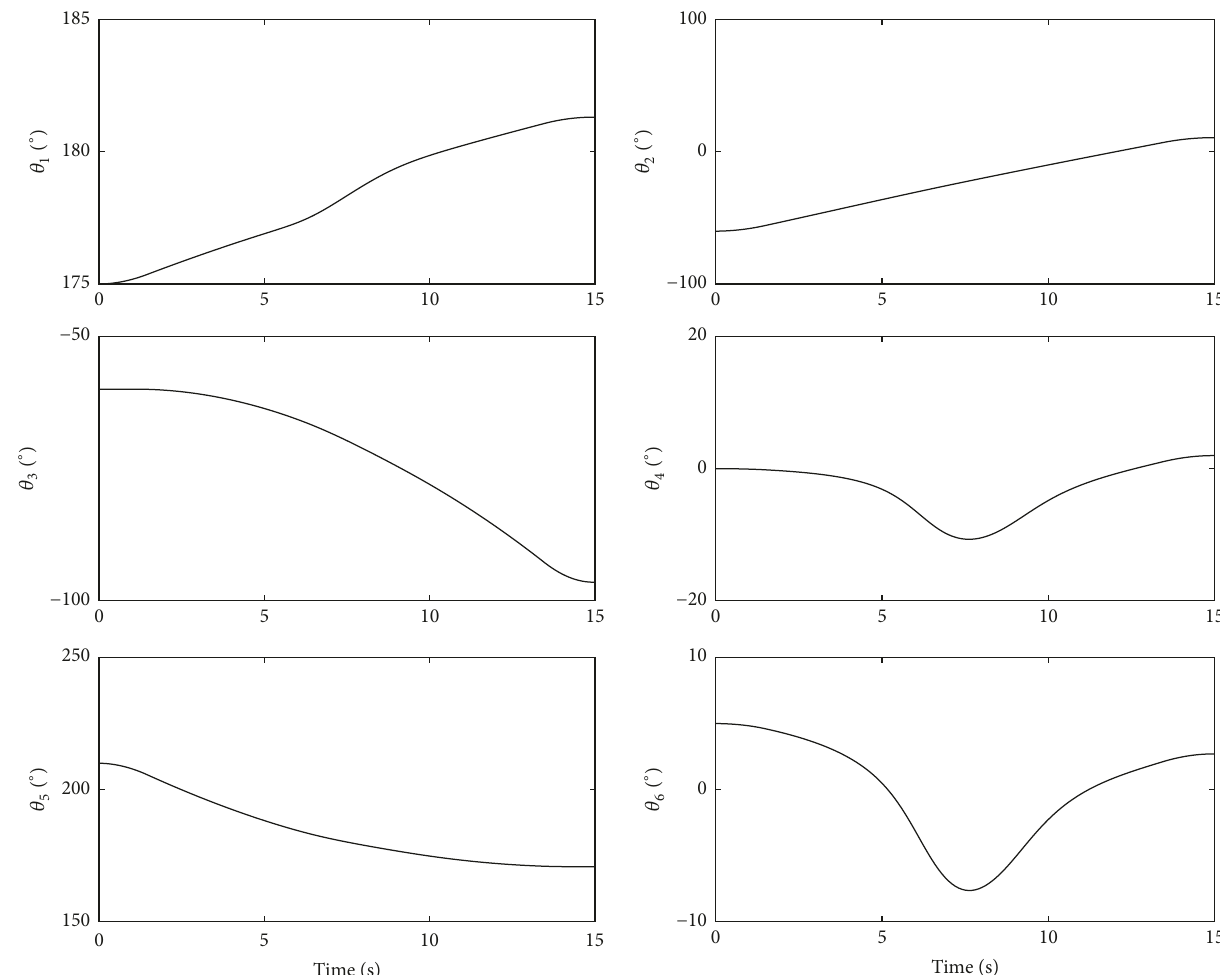
Figure 8: The joint position path planned by singularity-robust